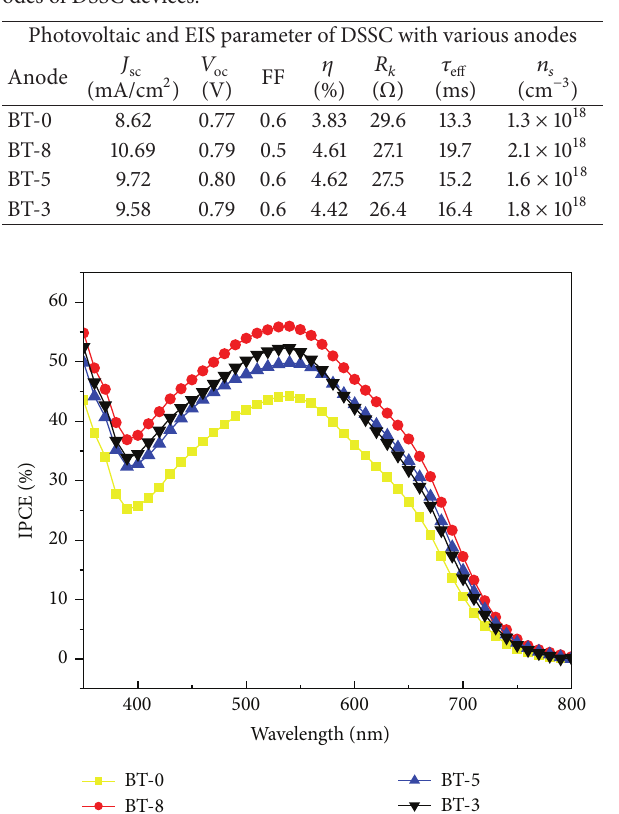
Table 1: Photovoltaic and EIS parameters by various TiO 2 photoan- odes of DSSC devices.